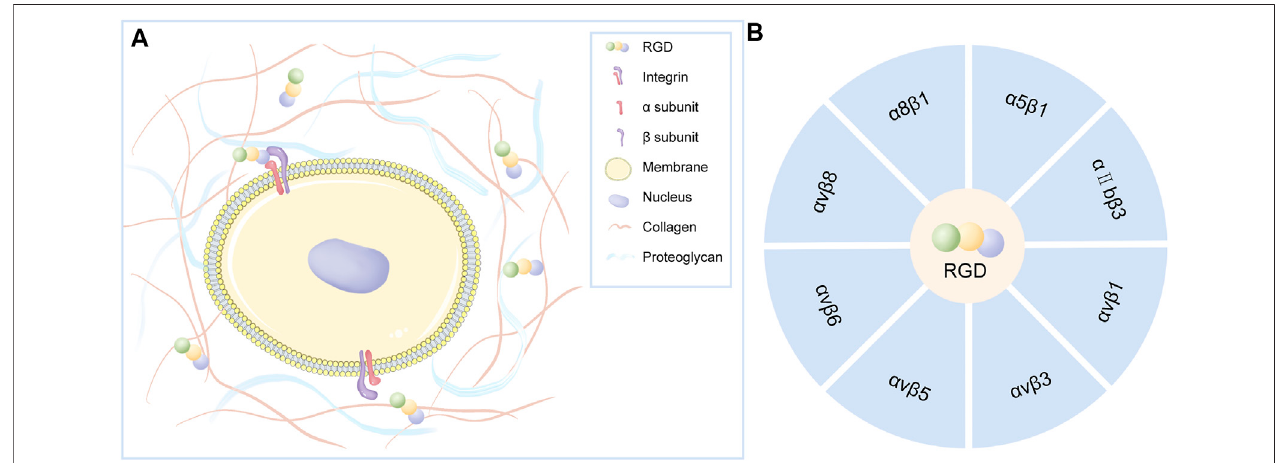
FIGURE 2 | (A) Integrins on the cell membrane are composed of α and β subunits that act as transmembrane receptors mediating cell attachment to the extracellular matrix. Certain integrins can speci fi cally recognize RGD polypeptides. (B) Integrin that speci fi cally recognizes RGD polypeptides.